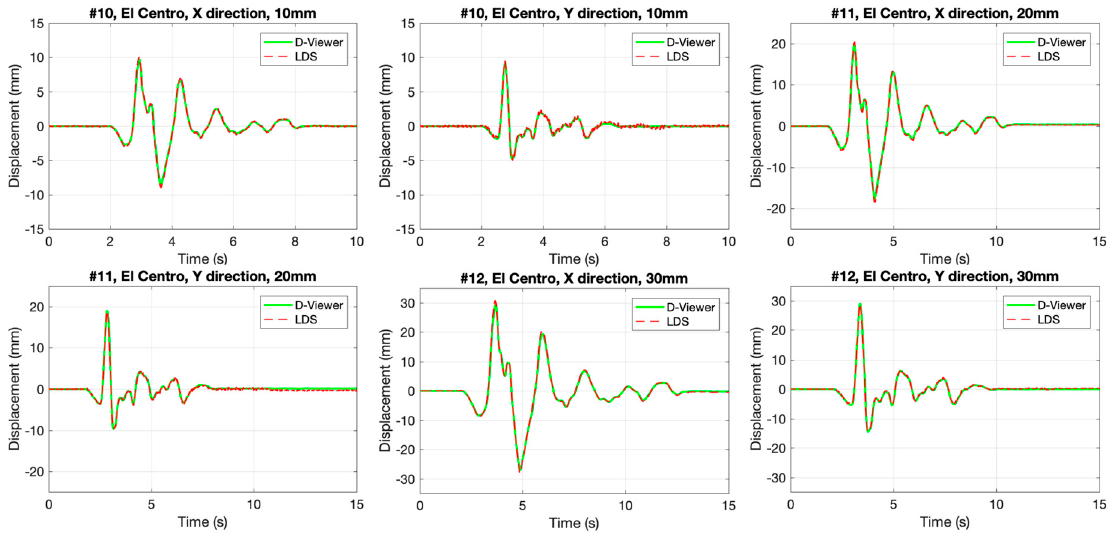
Figure A3. Experiment results of #10 to #12.